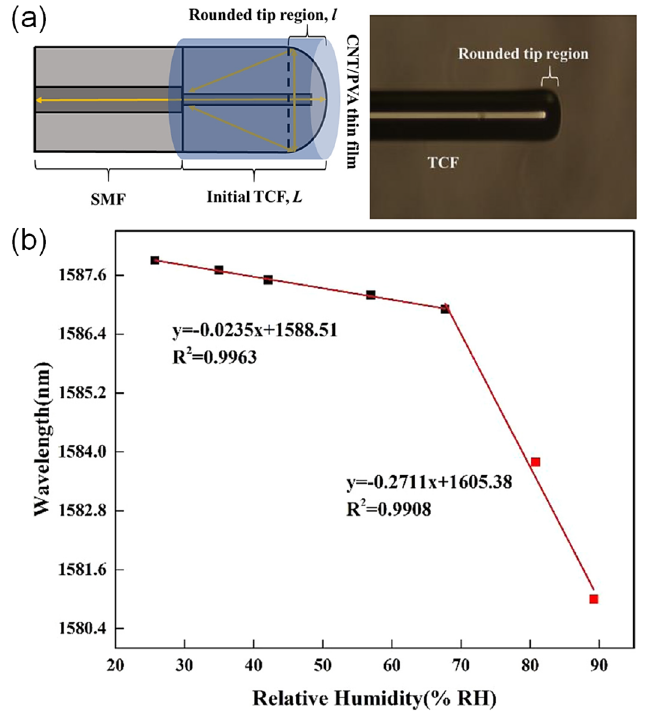
Figure 27. Point sensor. ( a ) Schematic of the sensor head and micrograph of the sensor head under 10x magnification. ( b ) Relationship between RH and wavelength. Reprinted with permission from ref. [131]. Copyright 2018 Elsevier